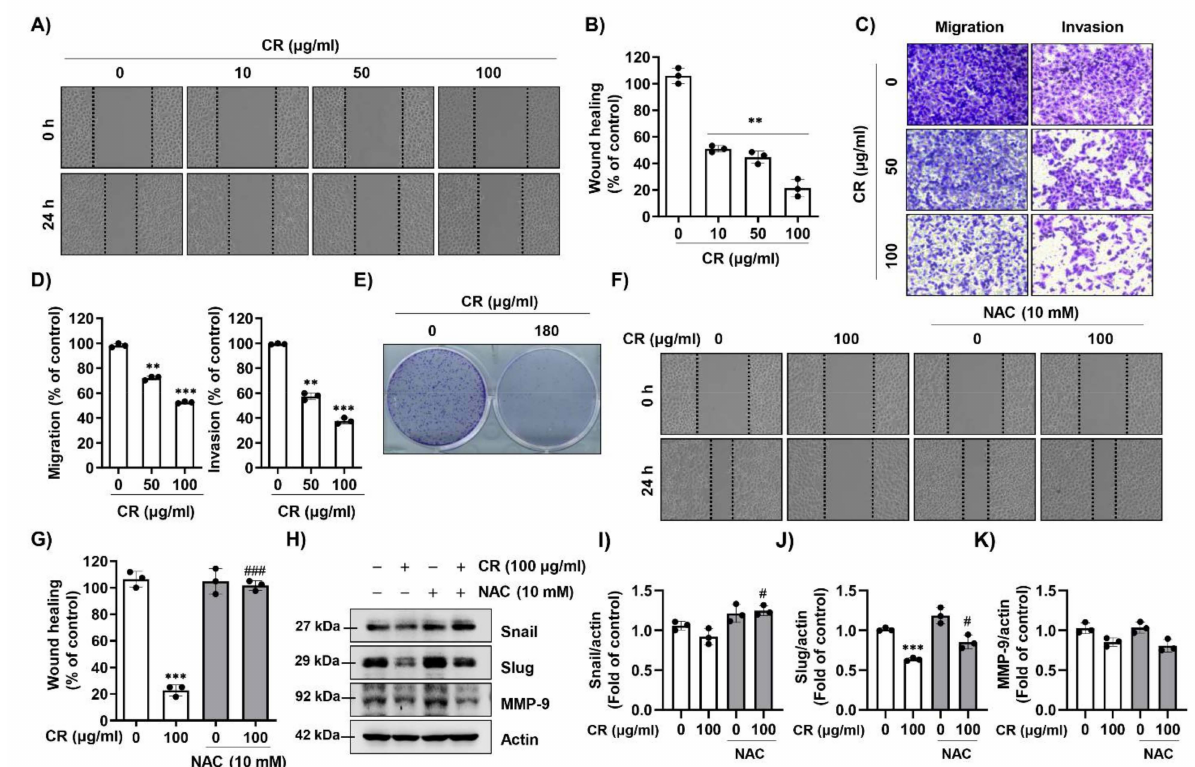
Figure 4. CR inhibits cell migration via ROS in Hep3B cells. ( A ) Cells were seeded, scratched, and treated with media contained 5% FBS and various concentrations (0, 10, 50, 100 µ g/mL) of CR for 24 h. The migration of cell was measured with a wound healing assay (magnification; 50 × ). ( B ) Mobility was calculated, as compared to the control cells. Each bar represents the mean ± SD of three independent experiments. ** p < 0.01 when compared to control. ( C ) Cell migration and invasion assays were assessed using a trans-well chamber system. Cells were seeded in the upper chamber with serum-free medium containing CR and complement medium was added in the lower chamber. After 24 h of CR treatment, cells were stained with 0.1% crystal violet, and observed by a phase-contrast microscope at 100 × magnification. ( D ) The numbers of migrating and invading cells were calculated, as compared with the control cells ( n = 3). ** p < 0.01 and *** p < 0.001 when compared to control. ( E ) Hep3B cells were exposed to CR for 7 days, followed by colony formation assay. Cells were stained with 0.5% crystal violet solution, and visualized colonies were observed under a phase-contrast microscope. ( F ) Cells were pre-treated with or without NAC for 1 h, and treated with the CR for 24 h, and then cell migration was confirmed using a wound healing assay (magnification; 50 × ). ( G ) Mobility was estimated, as compared with the control cells ( n = 3). *** p < 0.001 compared to control, and ### p < 0.001 compared to CR-treated cells. ( H – K ) After treatment with CR for 24 h, cells were lysed and equal amounts of proteins were analyzed using Western blot analysis to detect the expression of Snail, Slug, and matrix metalloproteinase-9 (MMP-9). Actin was used as a loading control. ( K ) Bar graphs indicate the relative band density in western blot analysis ( n = 3). *** p < 0.001 compared to control; # p < 0.05 compared to CR-treated